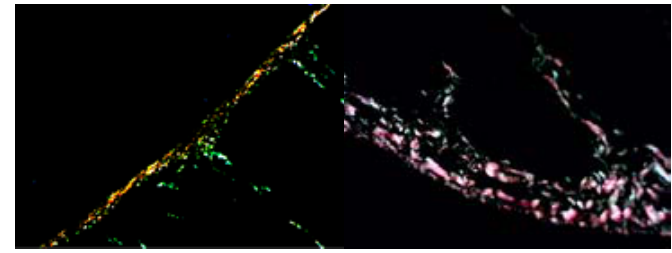
FIGURE 2 – Photomicrography of spleen and abdominal wall, control group, 21 days (Sirius Red-200x). Green: collagen III; Red or orange: collagen